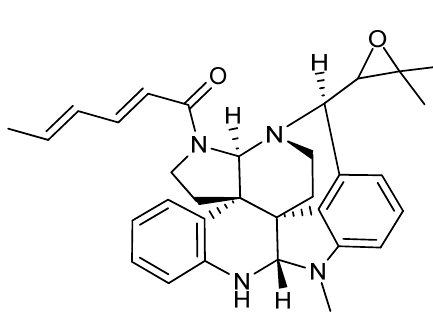
Figure 25. Communesin